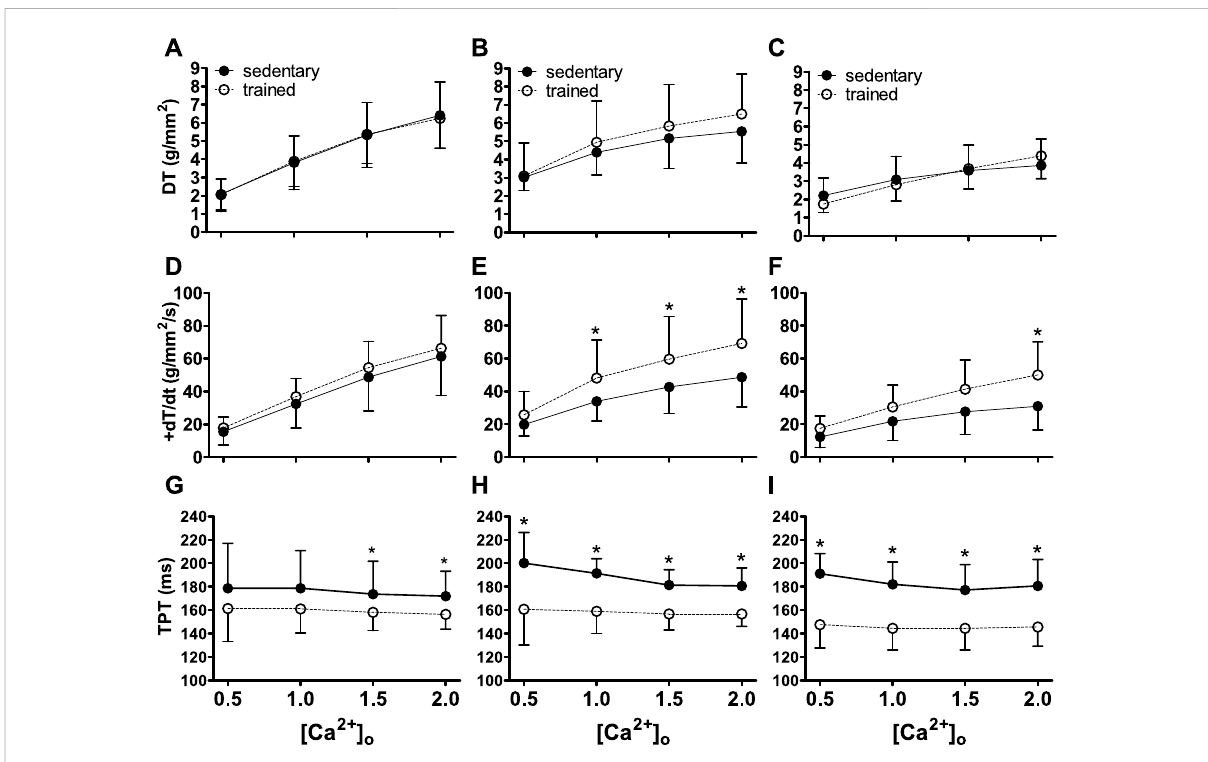
FIGURE 1 Inotropic function (DT, +dT/dt and TPT) of sedentary rats (solid symbols) and trained rats (empty symbols) with different myocardial infarction size after swimming exercise training. Inotropy was evaluated by different extracellular calcium concentrations [(Ca 2+ ) o ]. The myocardial infarction size: Sham operated (A,D,G) , Moderate MI (B,E,H) , and Large MI (C,F,I) . Comparisons between sedentary and trained rats: * p < 0.05. Values were expressed by mean ±